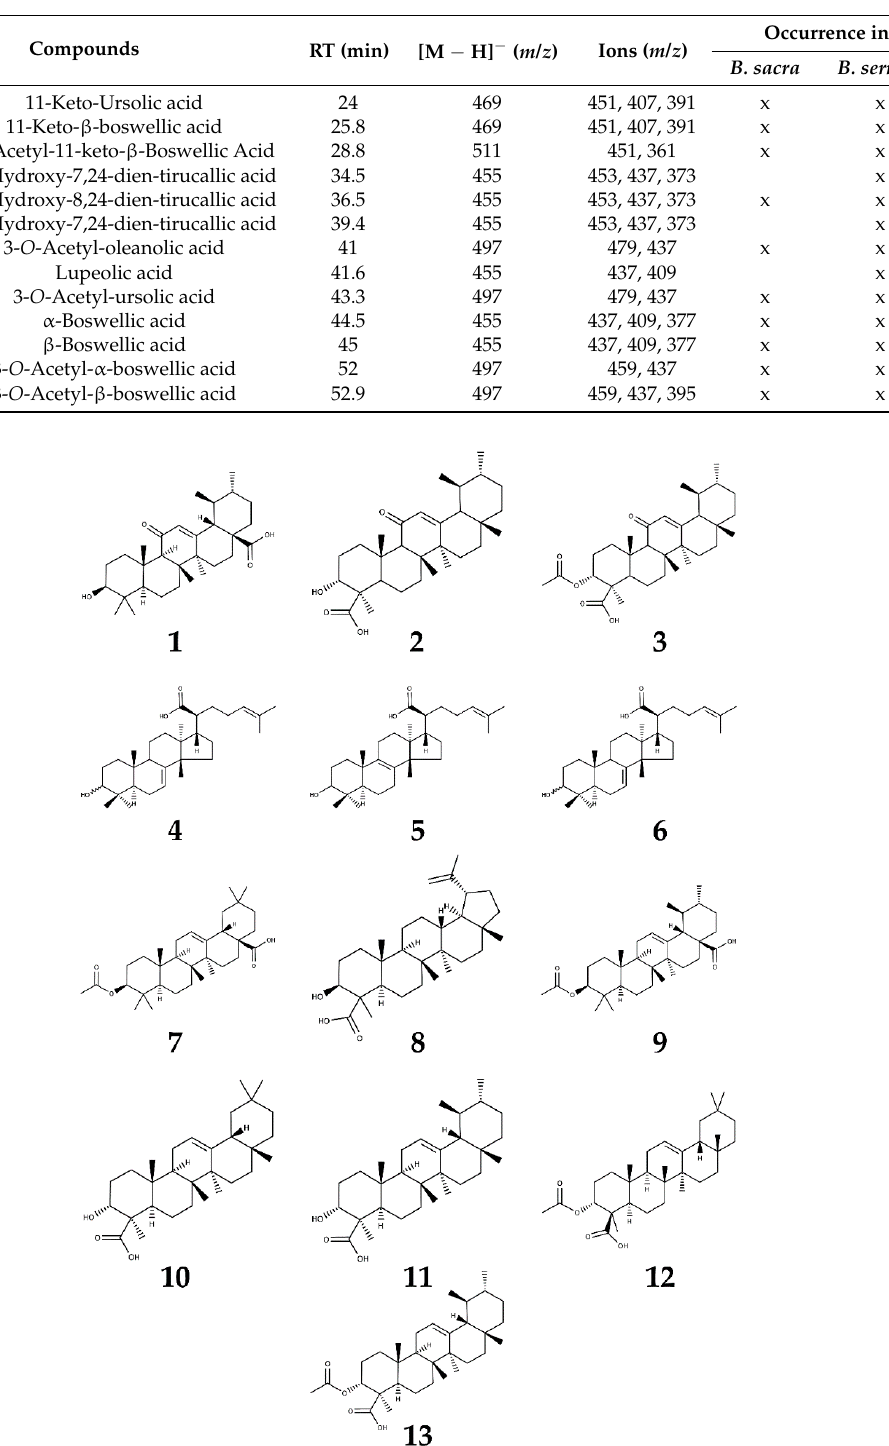
Table 1. Molecular mass and fragmentation pattern of compounds identified in the methanolic extracts of B. sacra and B. serrata .